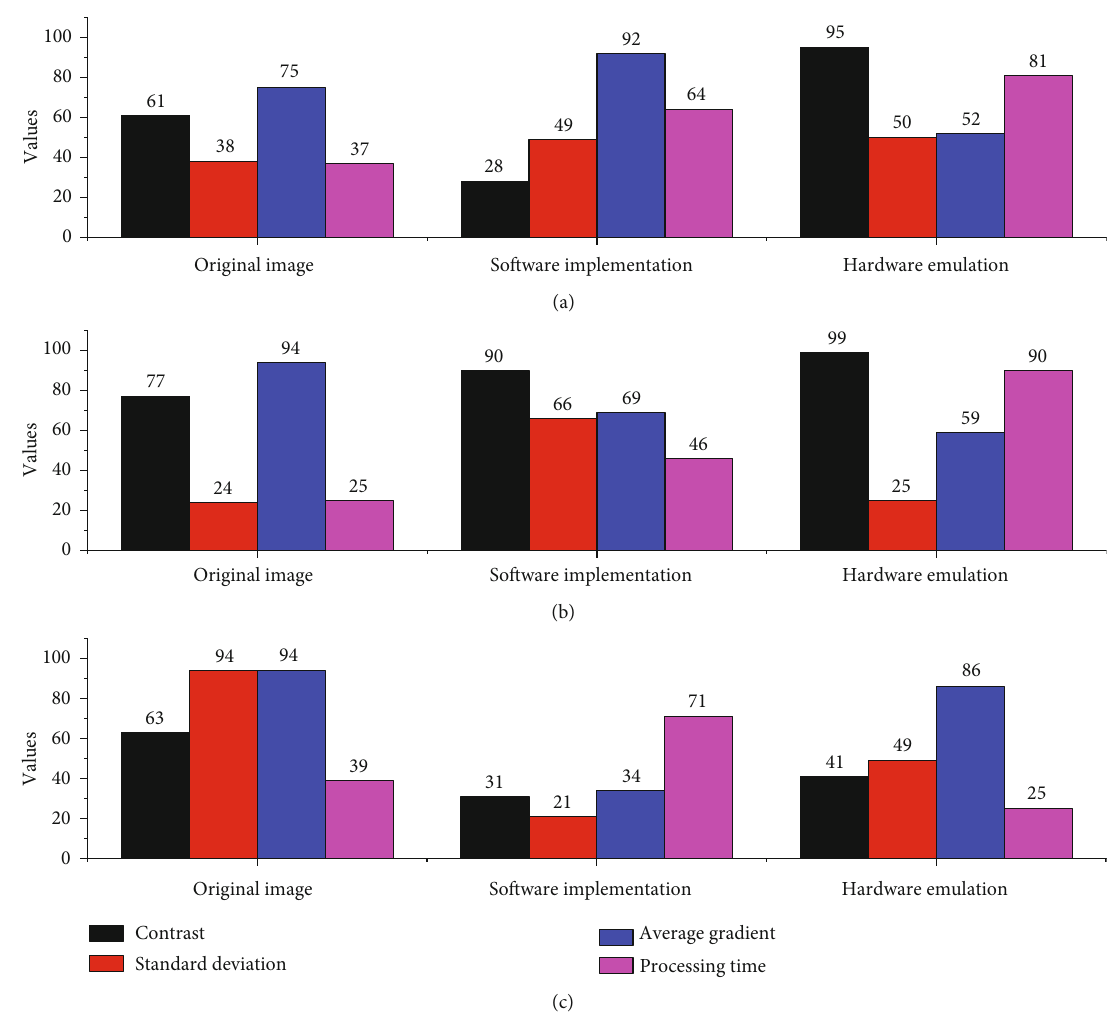
Figure 5: Parameter comparison